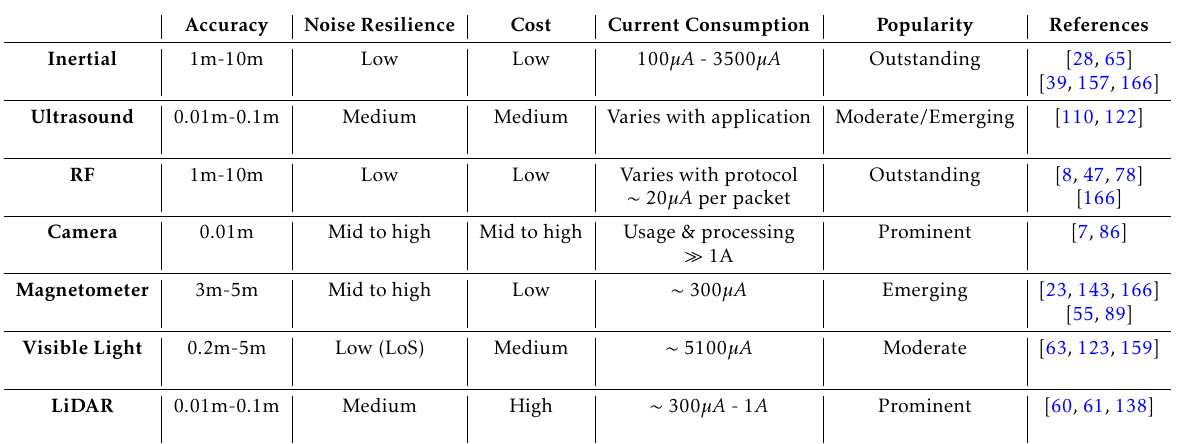
Table 2. Table of sensor modalities, evaluated using the criteria from Section 2.3. This table summarises the criteria of various sensing modalities, additionally giving the justifying references for